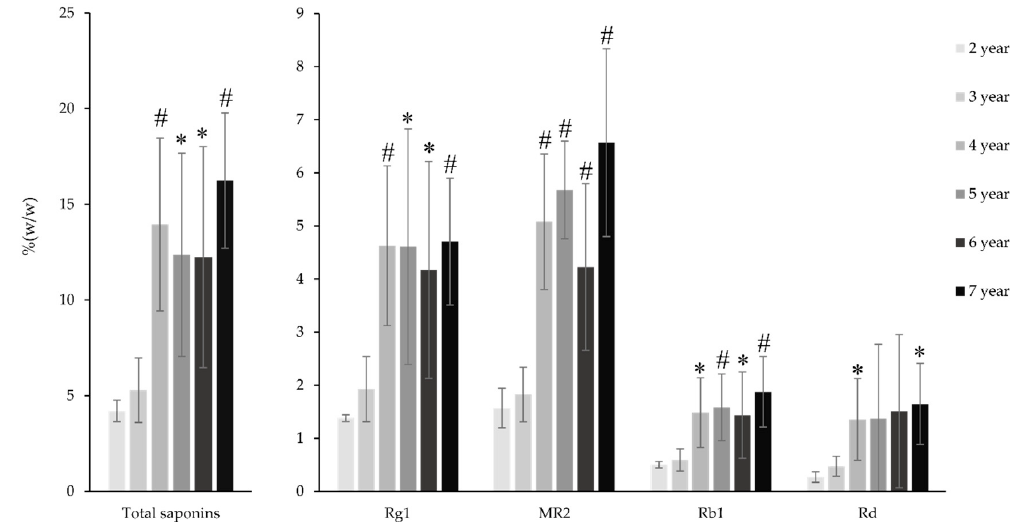
Figure 5. The change of saponin contents in the PV radix from 2–7 years. Results are expressed as mean ± SD ( n = 5), * p < 0.05, # p < 0.01 compared with that at the age at two years.